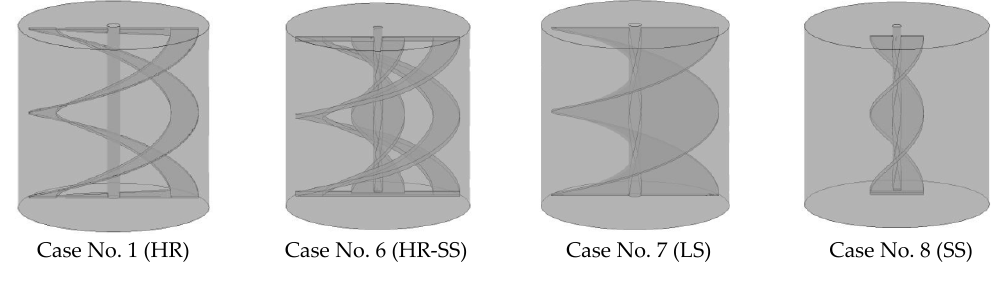
Figure 7. Stirred system.